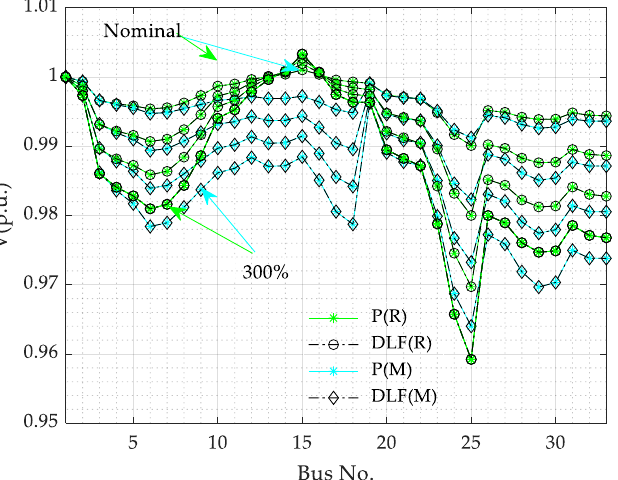
Figure 8. Voltage profile of the 33-node test feeder with a 300% increase in load and DG penetra- tion (100% increase in each step, Case 1, P = proposed, M = meshed).